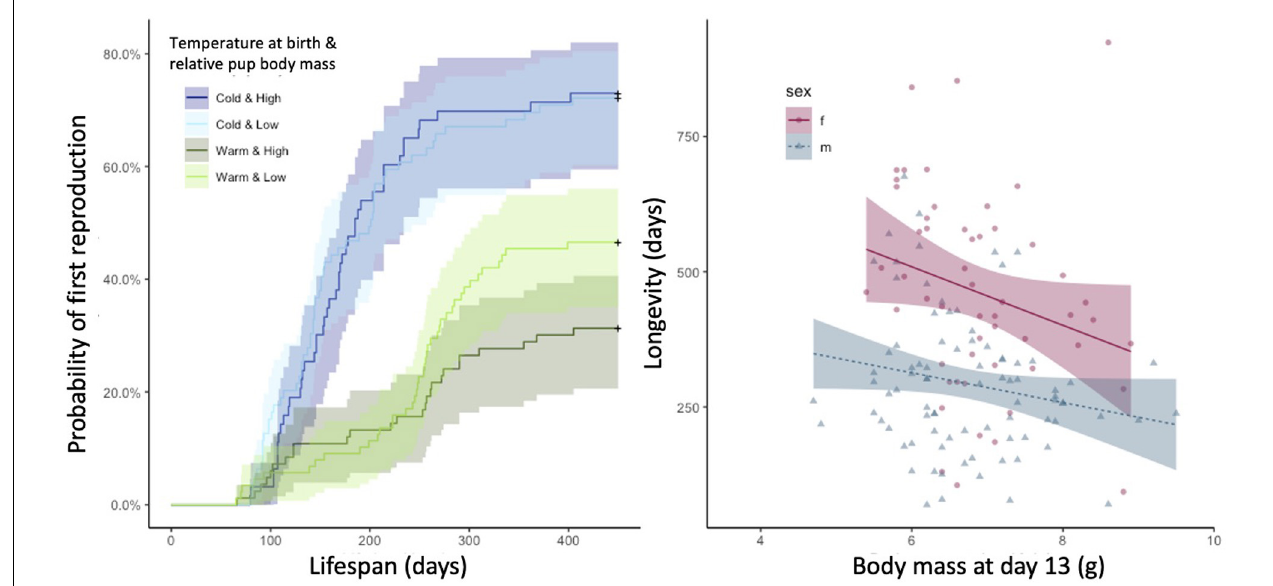
FIGURE 1 | Probability of onset of reproduction (left) and longevity (right) with pup body mass at day 13 and relevant interaction. The shaded areas indicate the 95% confidence intervals. Temperature at birth and pup body mass at day 13 were categorized for illustration. Values above the median were considered as high, respectively warm, and values below the median as low, respectively